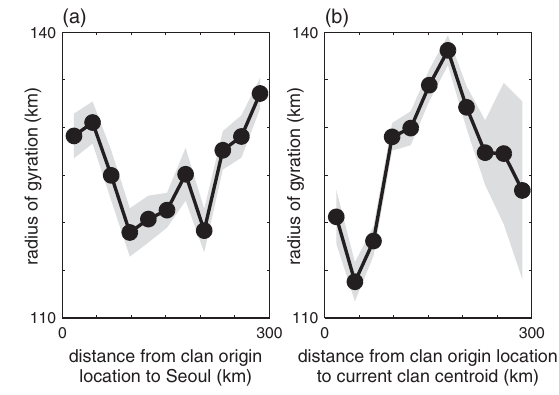
distance from clan origin location to Seoul (km) FIG. 22. Radii of gyration and distance scales of clans. (For this figure, we use the 3 120 clans that are present in both the 1985 and 2000 censuses and for which we could determine the origin location.) (a) Radius of gyration r versus distance to Seoul. The g Pearson correlation between the variables is not statistically significant ( r ≈ 0 . 18 ; the p -value is p ≈ 0 . 6 ). (b) Radius of gyration r versus distance between the clan origin location and the present- g day centroid. The Pearson correlation between the diagnostics is positive and statistically significant up to 170 km ( r ≈ 0 . 86 , p ≈ 0 . 01 ) and is negative and significant for larger distances ( r ≈ − 0 . 96 , p ≈ 0 . 005 ). For each of the panels, we estimate r g separatelyineachof11equally-sizedbinsforthe displayedrangeof distances. The gray regions give 95% confidence